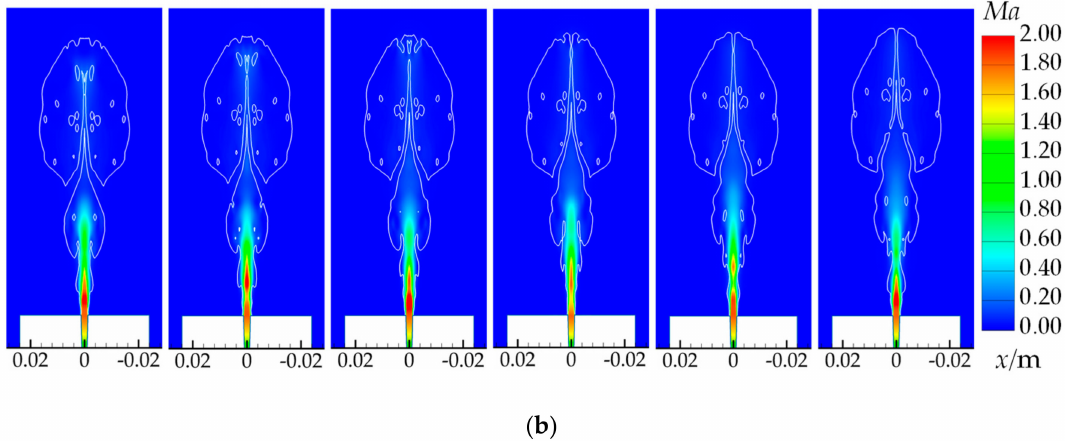
Figure 17. Numerical results of pressure and Mach number distribution (100 m, ∆ t = 0.1 ms) ( a ) contour of pressure ( b ) contour of Mach number.